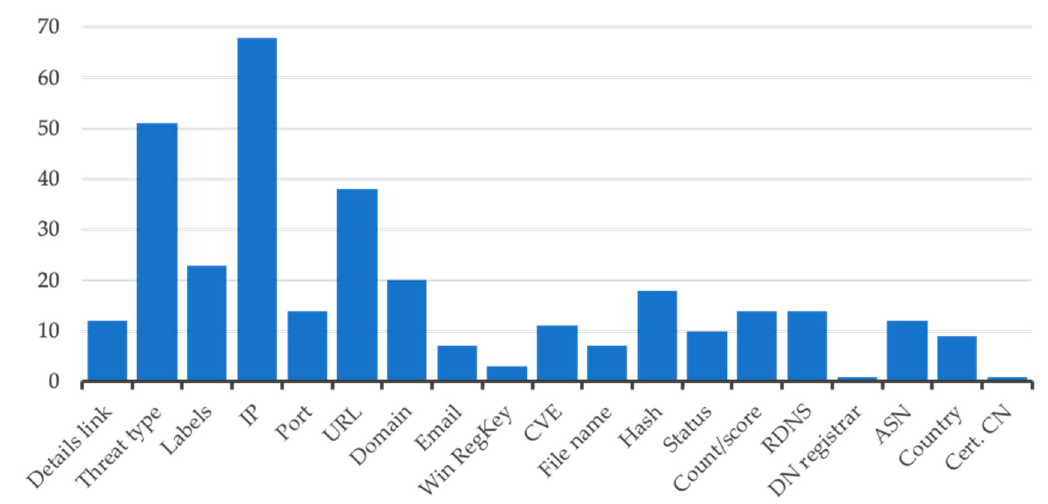
Figure 2. CTI types represented. Figure 2 . CTI types represented . Figure 2 . CTI types represented .